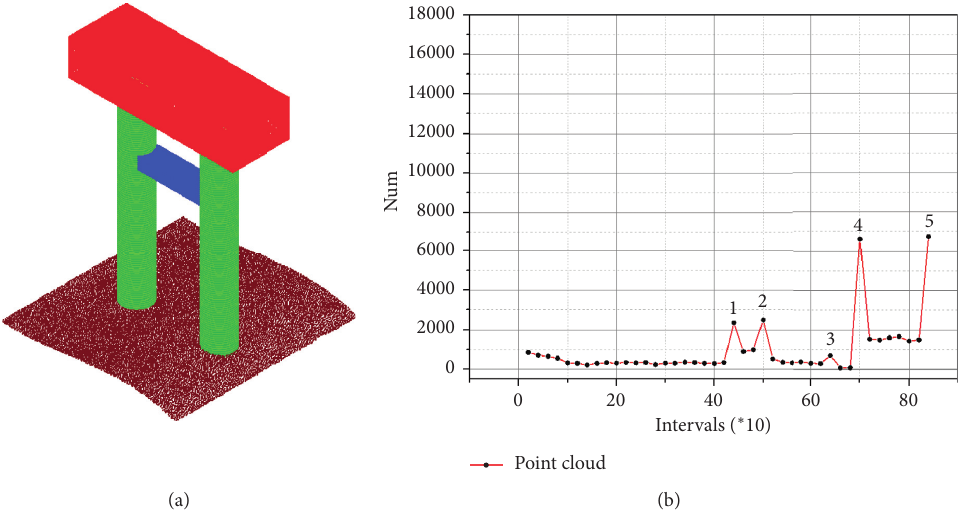
Figure 6: Group 2 theoretical point cloud: (a) nonplanar ground point cloud; (b) Z-axis stacking direction interval density of the point cloud.